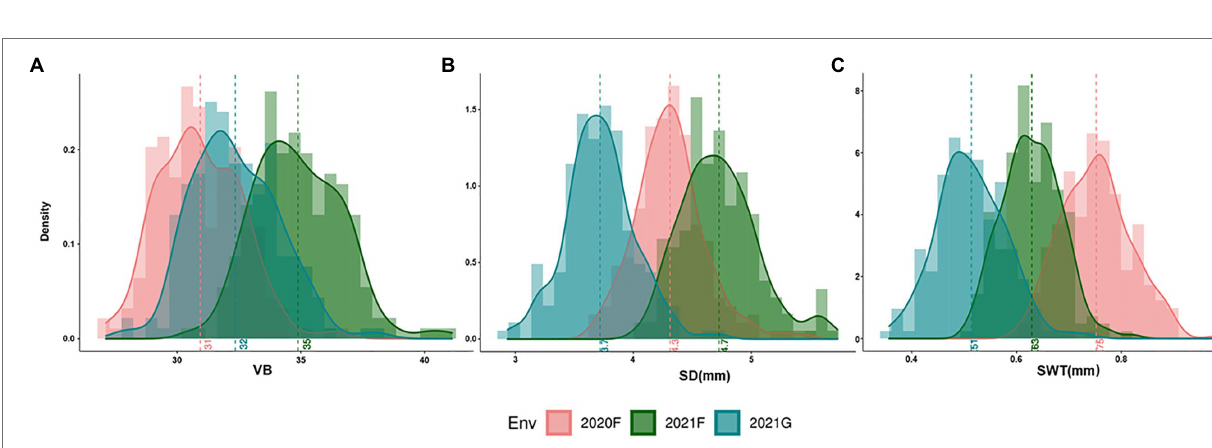
FIGURE 3 | Phenotypic distributions of VB (A) , SD (B) and SWT (C) in three environments. VB: number of big vascular bundle; SD: stem diameter; SWT: stem wall